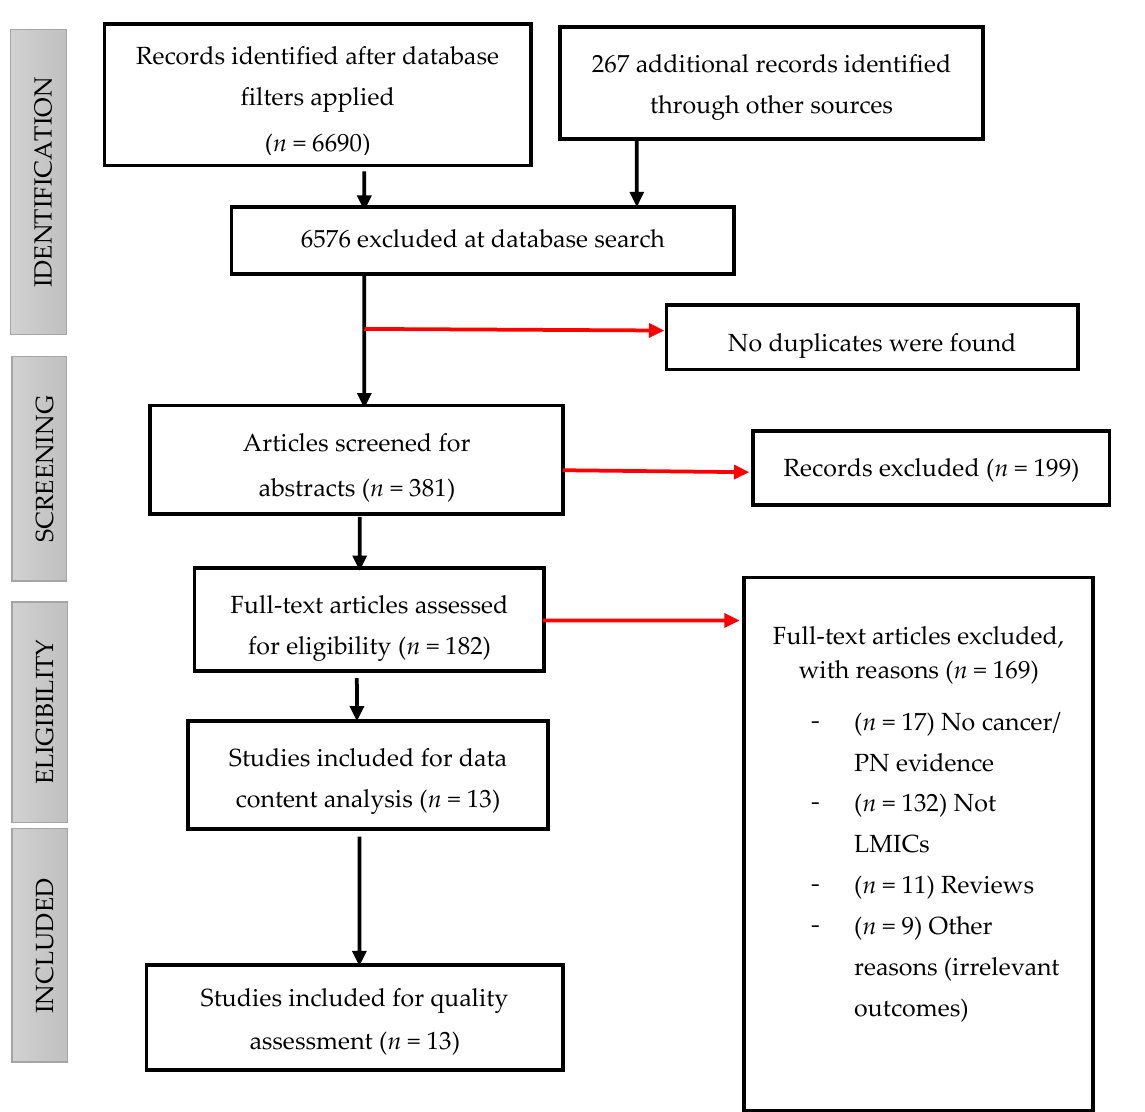
Figure 1. PRISMA-ScR flow chart demonstrating the screening results of each stage.